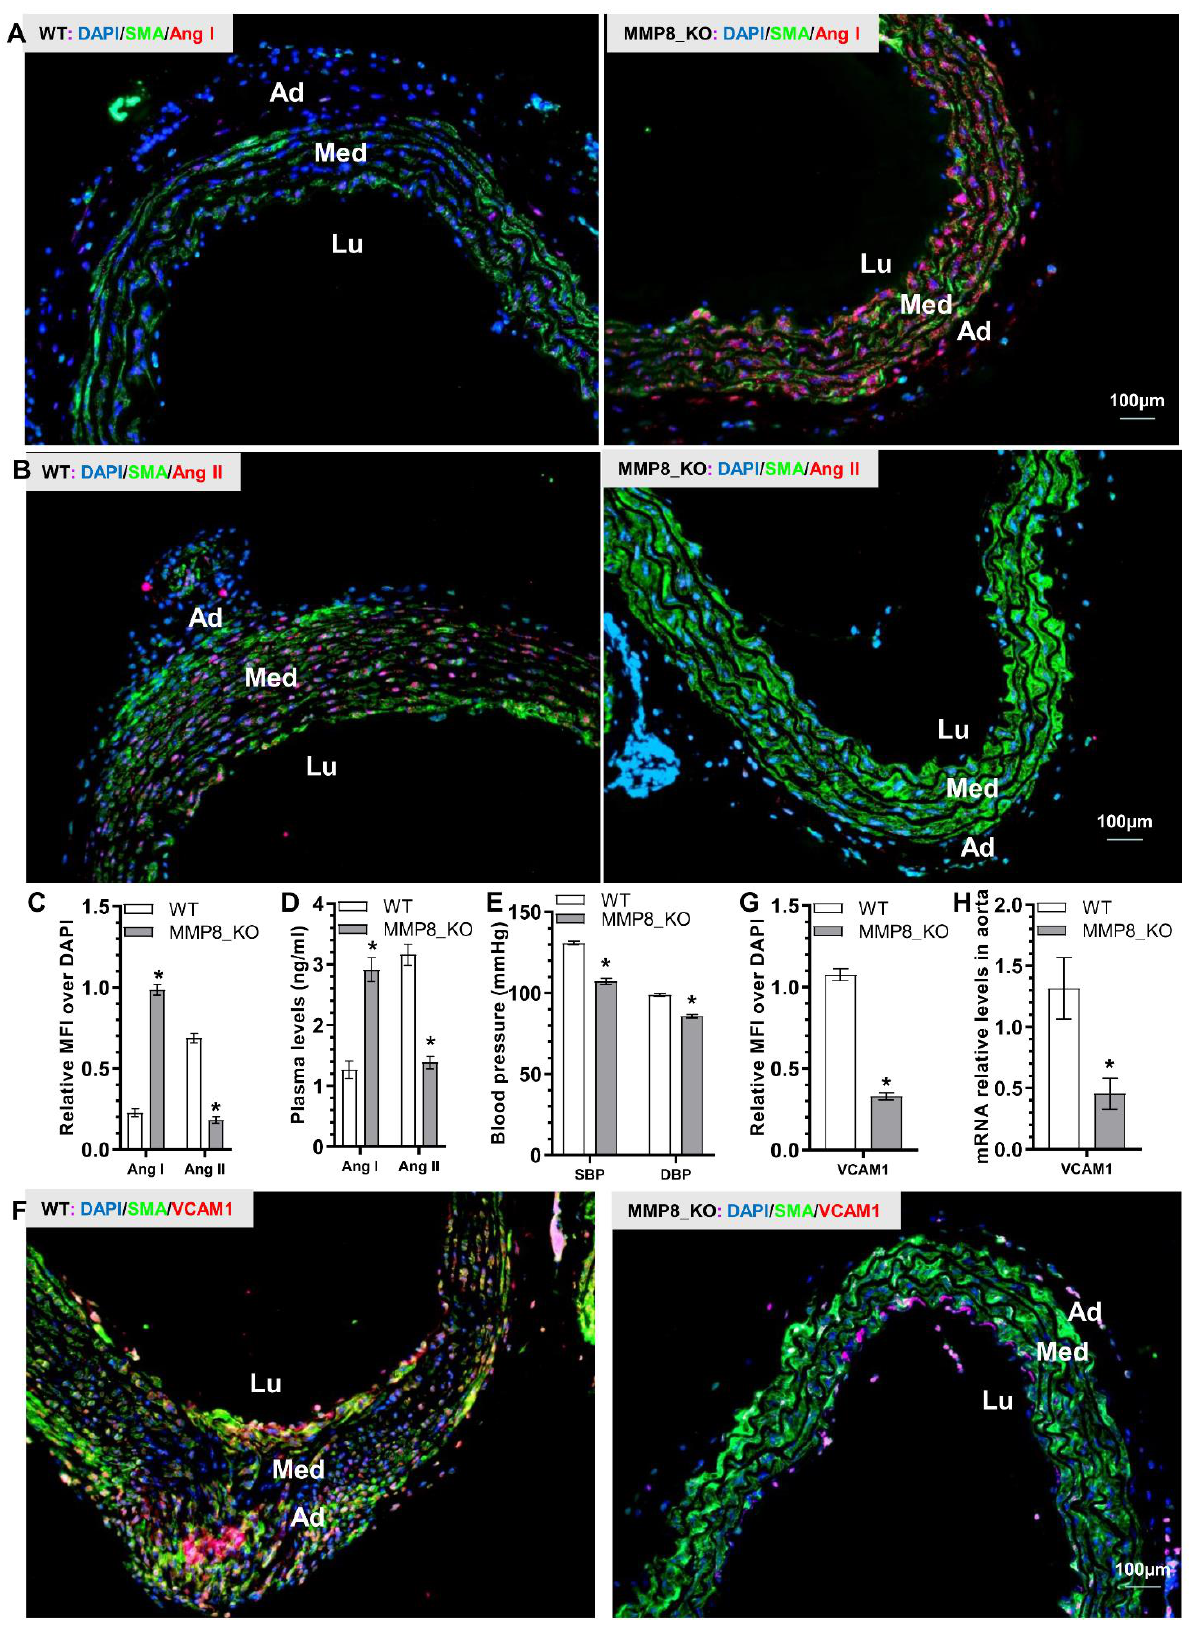
Figure 4. Reduced Ang II levels, lower blood pressure, and decreased VCAM-1 expressions were observed in MMP8_KO mice. Three week-old WT and MMP8_KO mice were administered with BAPN in drinking water for two weeks, thoracic aortic tissues and plasma were collected for